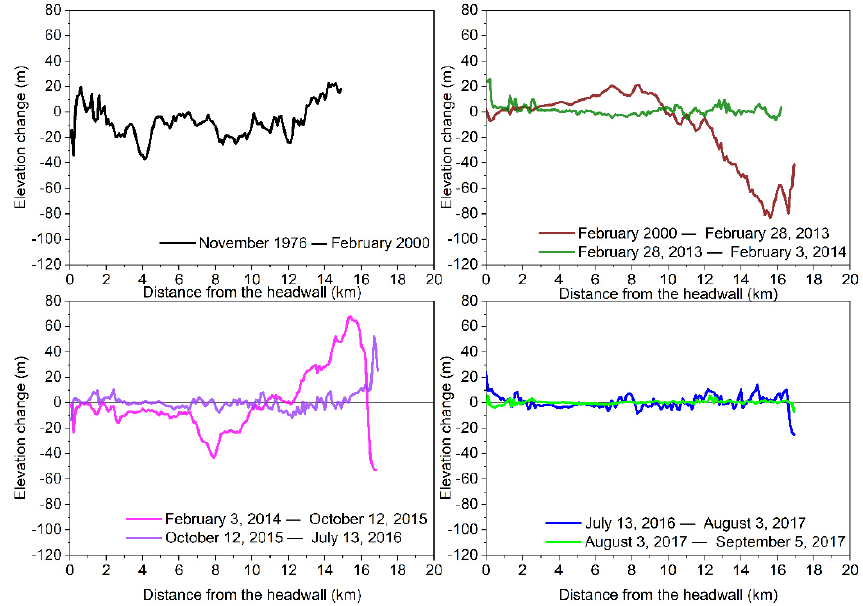
Figure 10. Glacier elevation change profiles in different periods (the longitudinal profile in Figure 1).